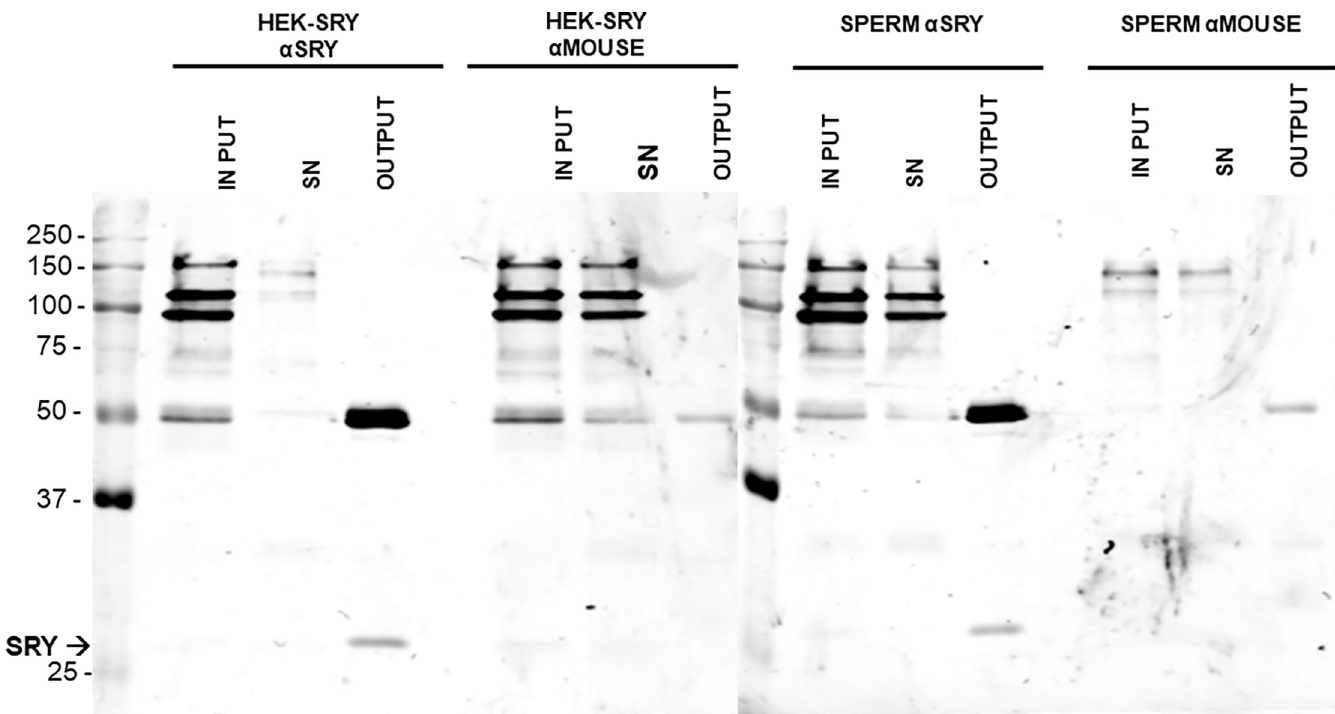
Fig 6. SRY binding to SRY0 and SRY2 sites in the CATSPER1 promoter. Immunoblotting for SRY in samples from ChIP assays. Chromatin from pIRES-SRY transfected HEK-293 cells (HEK-SRY) and immature spermatogenic cells from human semen (SPERM) was probed in immunoprecipitation assays using anti-mouse IgG, SRY ( α -SRY) and α -dystroglycan ( α -MOUSE) antibodies. A sample of 2.5% of input, 2.5% of supernatant (SN) and 10% of bound protein to beads (output) was immunodetected with the SRY specific antibody in each condition. The arrow indicates the SRY signal.